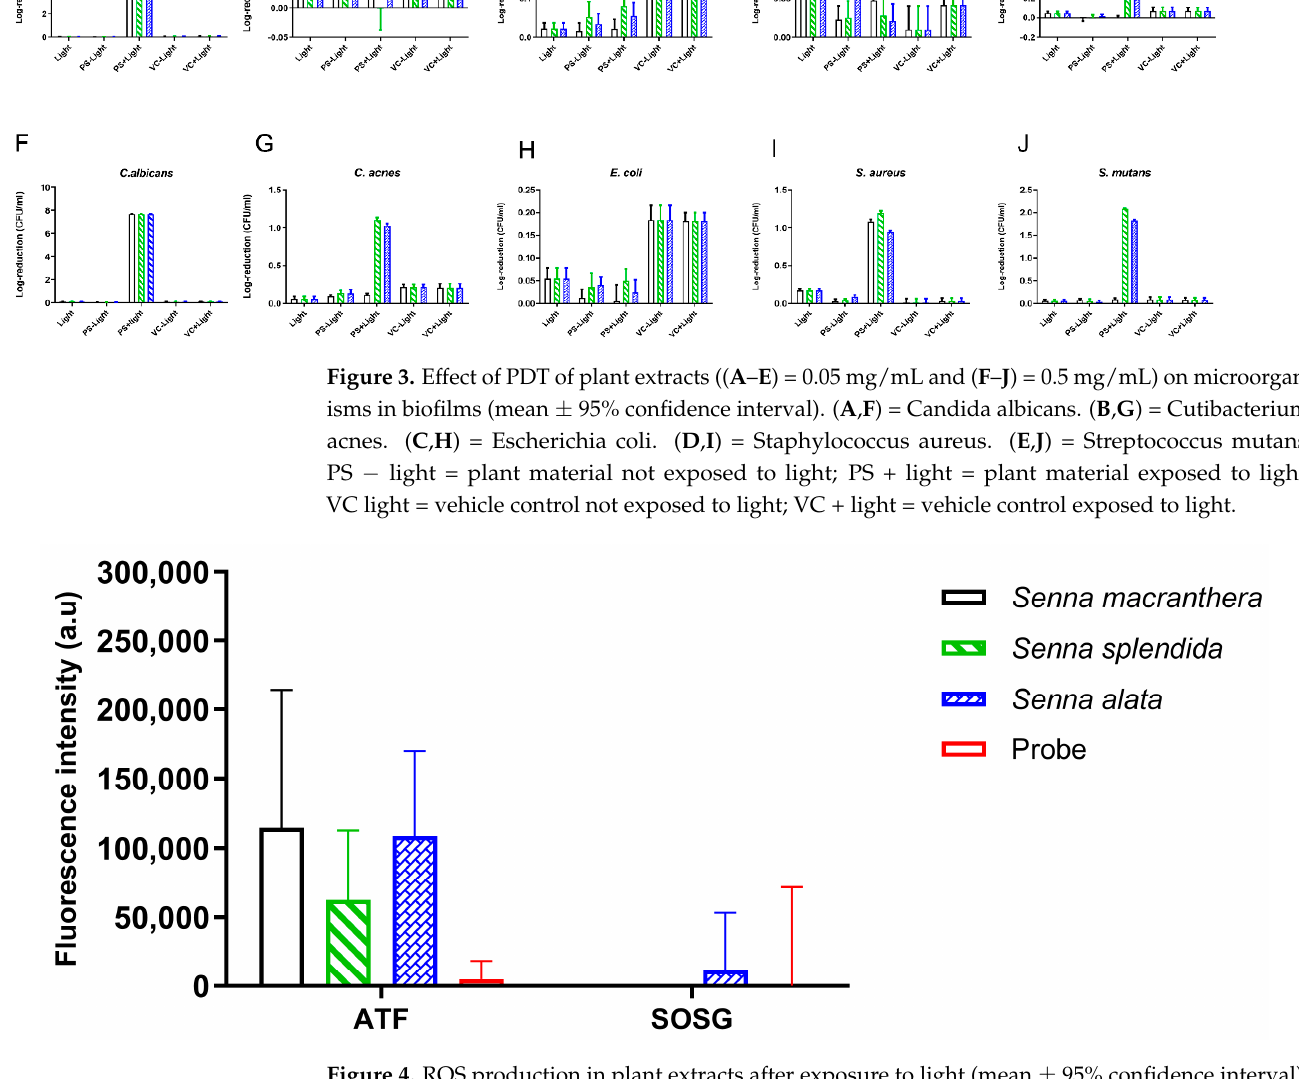
Figure 4. ROS production in plant extracts after exposure to light (mean ± 95% confidence interval).